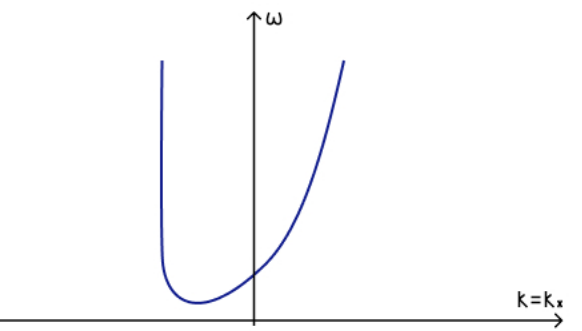
Figure 16. Dispersion curve of low-frequency magneto-Rossby